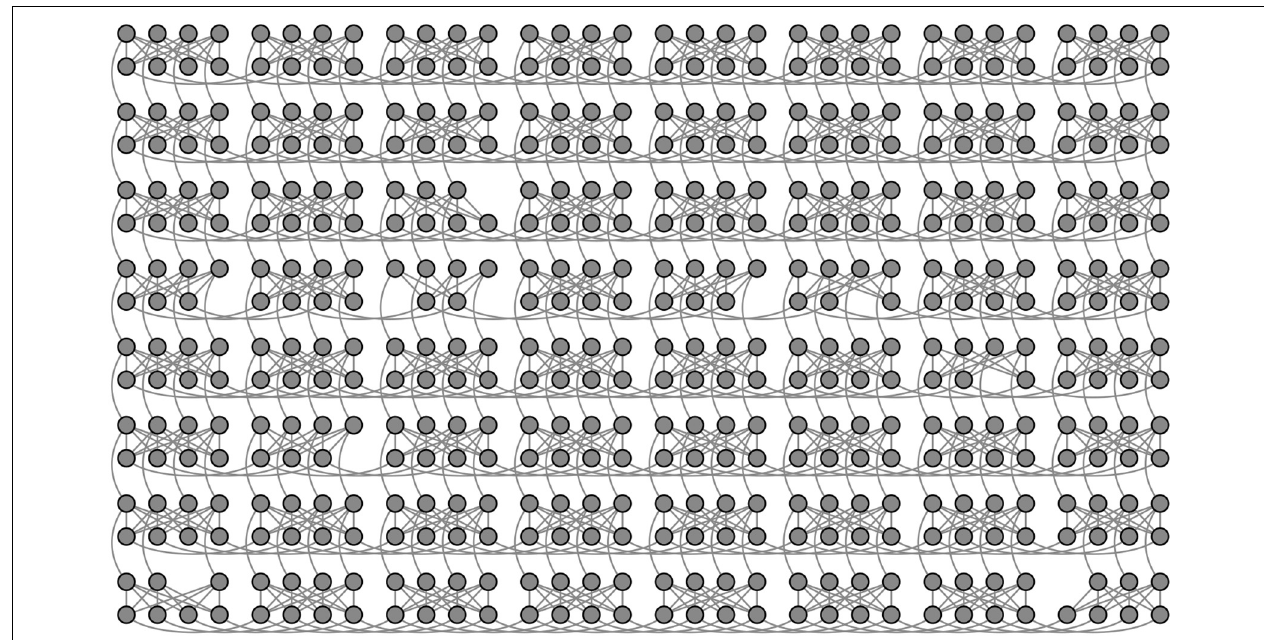
The detrimental impact of hardware limitations (1) and (2)